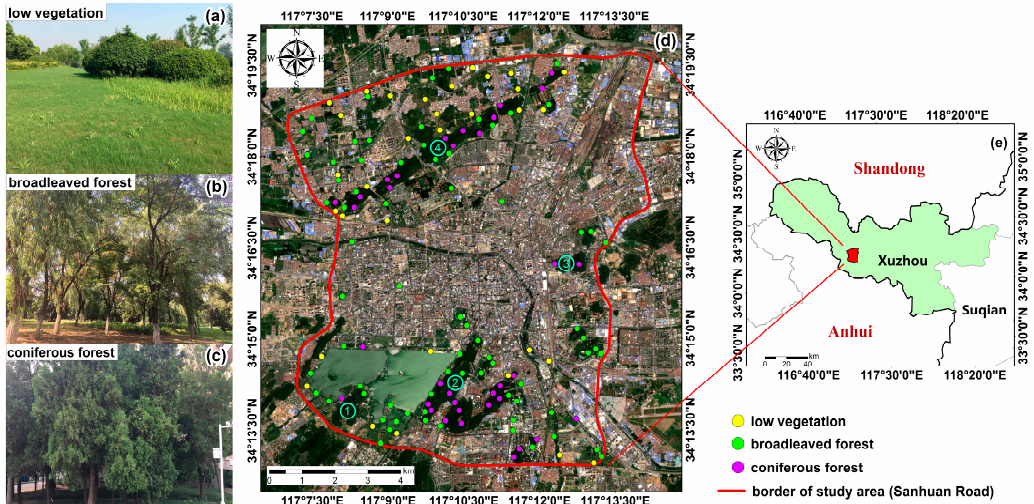
Figure 1. The location of the study area: ( a – c ) field photos illustrating three di ff erent urban forest types; ( d ) sites for field investigation (yellow for low vegetation, green for broadleaved forest, and purple for coniferous forest), the border of the study area, and a true-color composition of the Sentinel-2A image used for classification. Labels ① – ④ refer to the hills of Zhushan, Yunlong, Zifang, and Jiuli, respectively; ( e ) study area in Xuzhou.